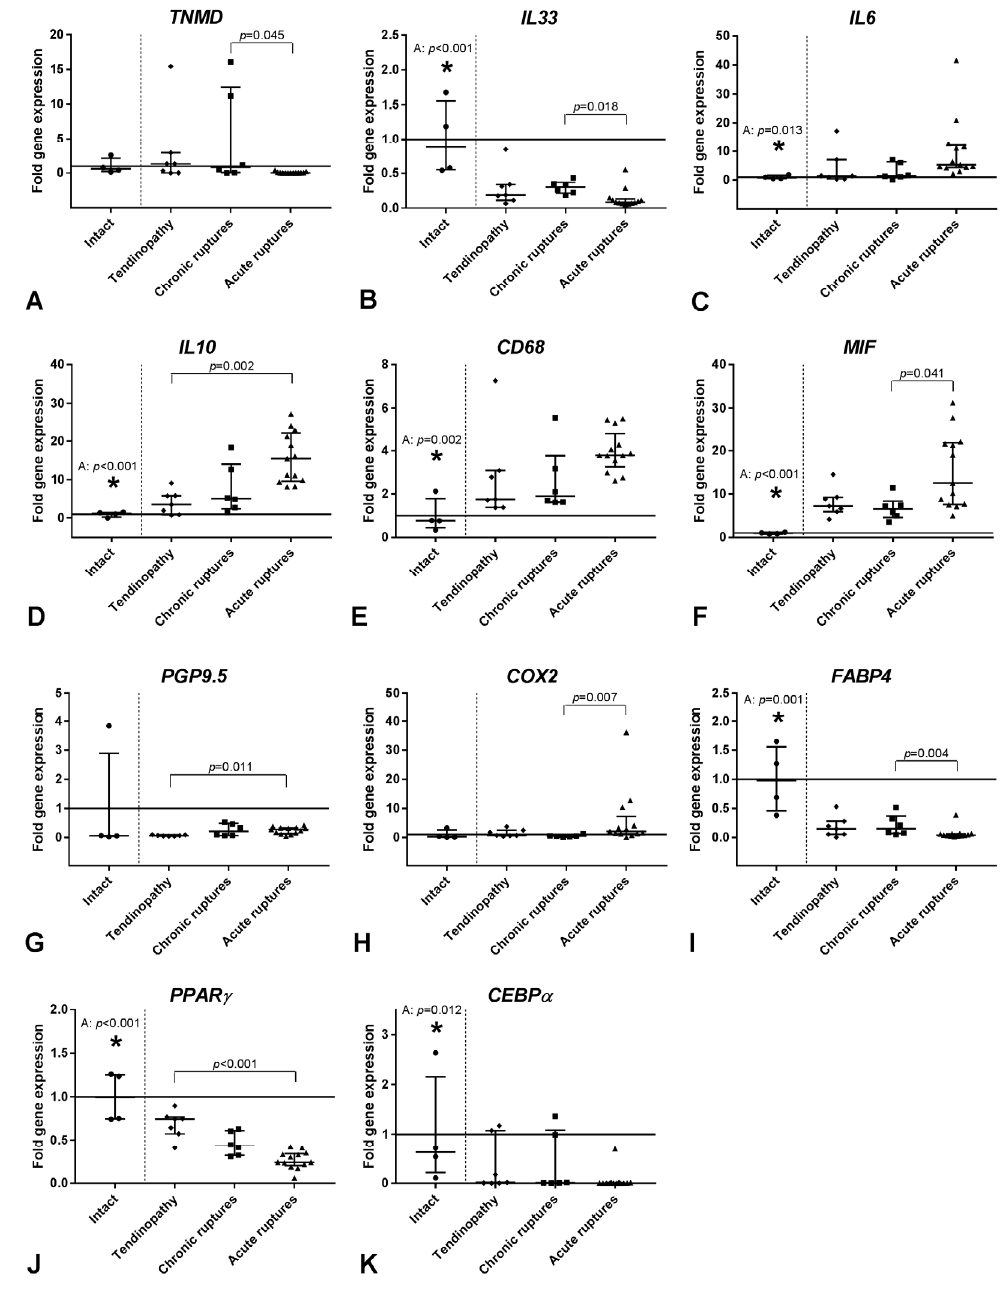
Figure 5. Relative gene expression of TNMD ( A ), the inflammatory cytokines IL33 , IL6 and IL10 ( B – D ), the immune cell marker CD68 ( E ), the nerve markers MIF and PGP9.5 ( F – G ), the pain marker COX2 ( H ), and the fat markers FABP4 , PPAR γ and CEBP α ( I – K ) in tendinopathic tendons, chronic ruptures and acute ruptures given as fold to intact tendon tissue (horizontal line, mean value = 1). qRT-PCR data were normalized to the expression of the house keeping gene 18S rRNA with efficiency correction and presented as fold change to the mean of the intact tendons. Results are shown as individual dot plots with median and interquartile range. Significant differences between the intact tendons and the three tendon pathology groups are marked with a star (*) above the intact tendon and the respective significant group (T: tendinopathy, C: chronic ruptures, A: acute ruptures) and the p -value. The vertical dashed line separates the intact group from the tendon pathology groups. Significant differences between the three tendon pathology groups are marked with a spanning line above the groups and the individual p -values. p ≤ 0.05 was considered as statistically significant.